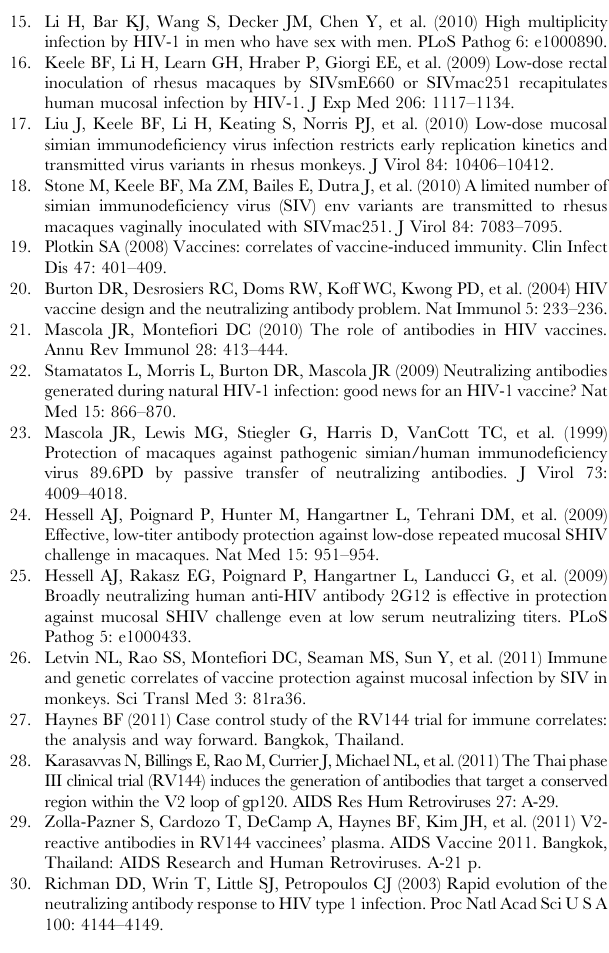
Figure S4 Estimation of Nab efficacy to block de novo infections. Using the data on the loss of the T/F sequence, we estimate the average efficacy of the Nab response at blocking de novo infections by the T/F virus. Our model assumed that the Nab response started at t ~ 0 and had a constant average efficacy a . The rate of the loss of the founder virus e was directly proportional to the average in vivo efficacy of the Nab response, a ~ e = r z c , where r is the average rate of virus replication and c is the cost of escape mutations. The estimated escape rate was e ~ 0 : 073 d { 1 and 0 : 099 d { 1 for CH40 and CH77 (SGA, panel A) and e ~ 0 : 11 d { 1 and 0 : 096 d { 1 for CH40 and CH77 (PASS, panel B), respectively. Model predictions are shown in (A) and (B) by lines. The estimates of the average Nab efficacy were independent of the time at which Nab response started as long as that time was earlier than 45 (CH40) and 50 (CH77) days post-seroconversion.